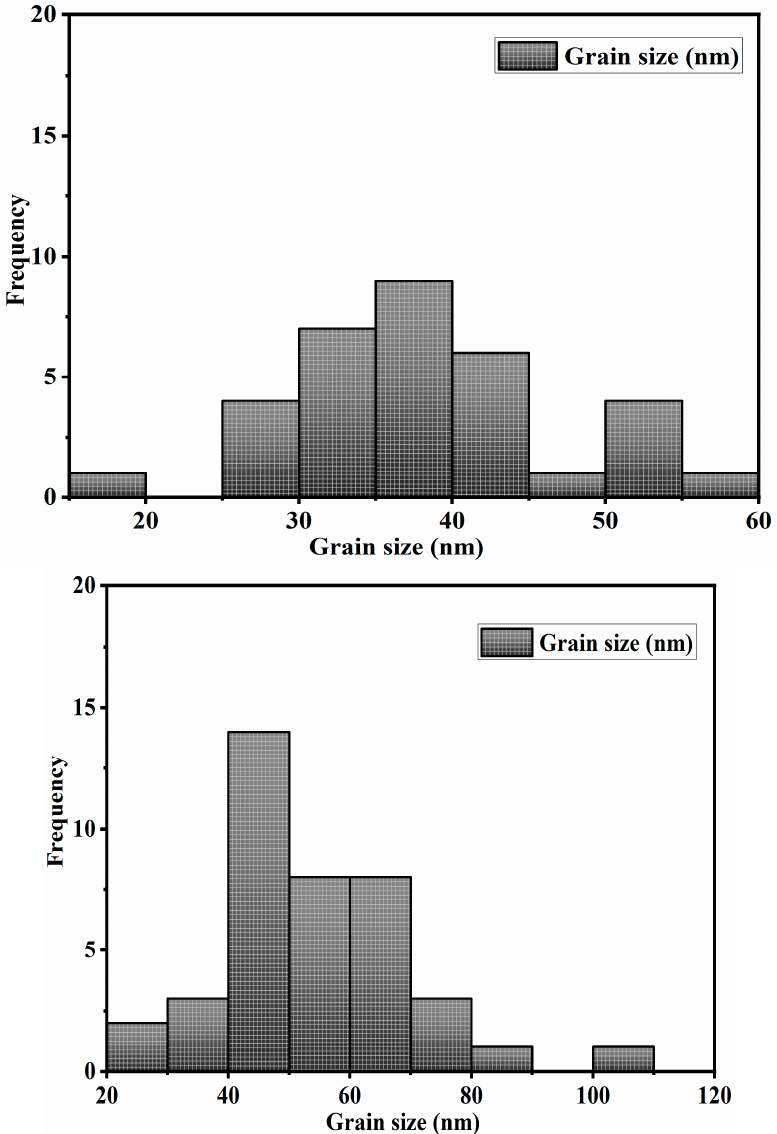
Figure 5. Histogram of distribution of particles of CoFe 2 O 4 and Co 0.1 Al 0.03 Fe 0.17 O 0.4.